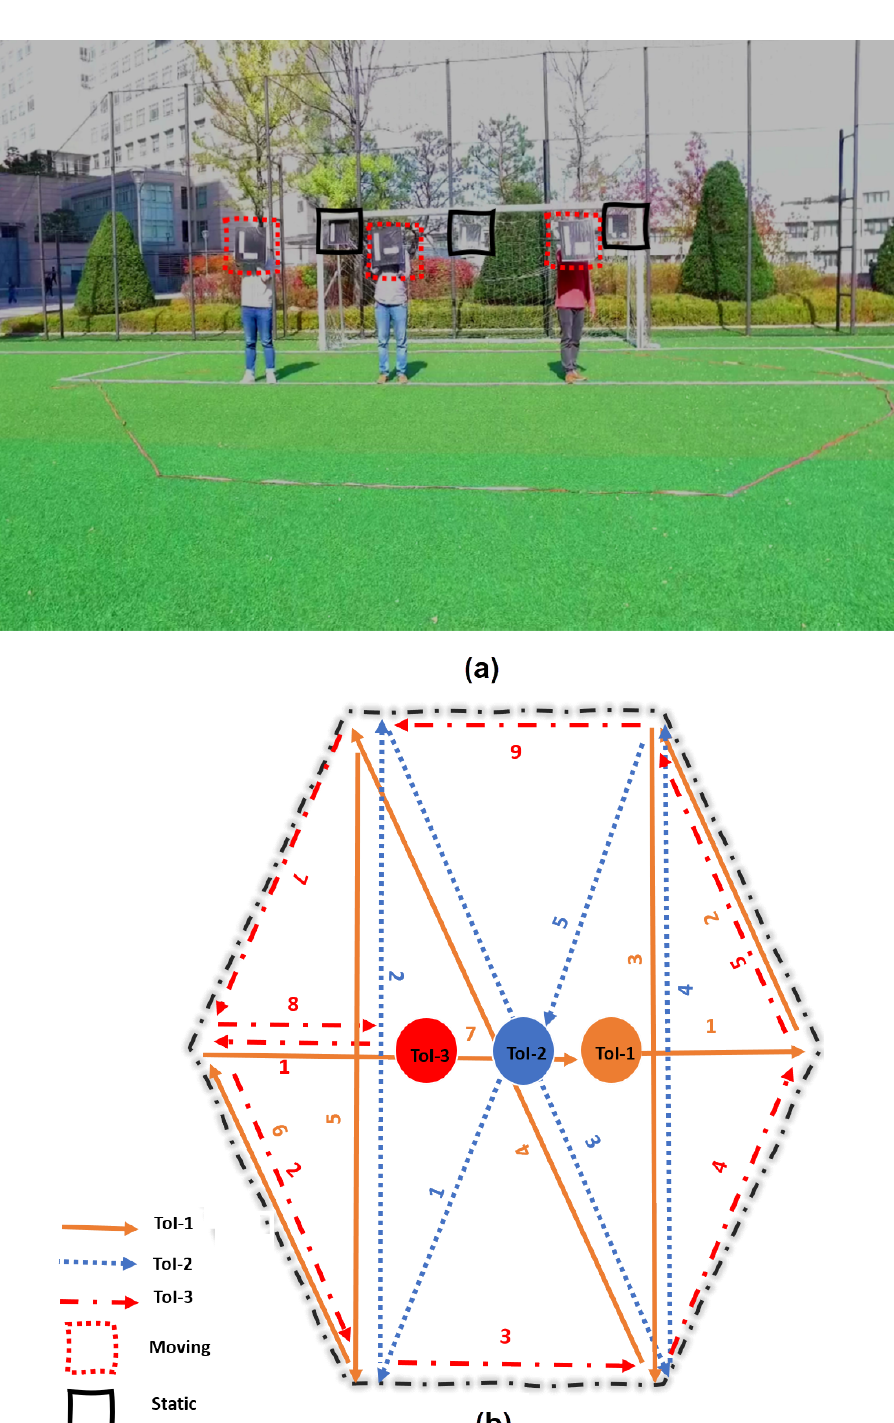
Figure 6. Experiment 2: ( a ) ToI physical setup in an outdoor environment; ( b ) ToI